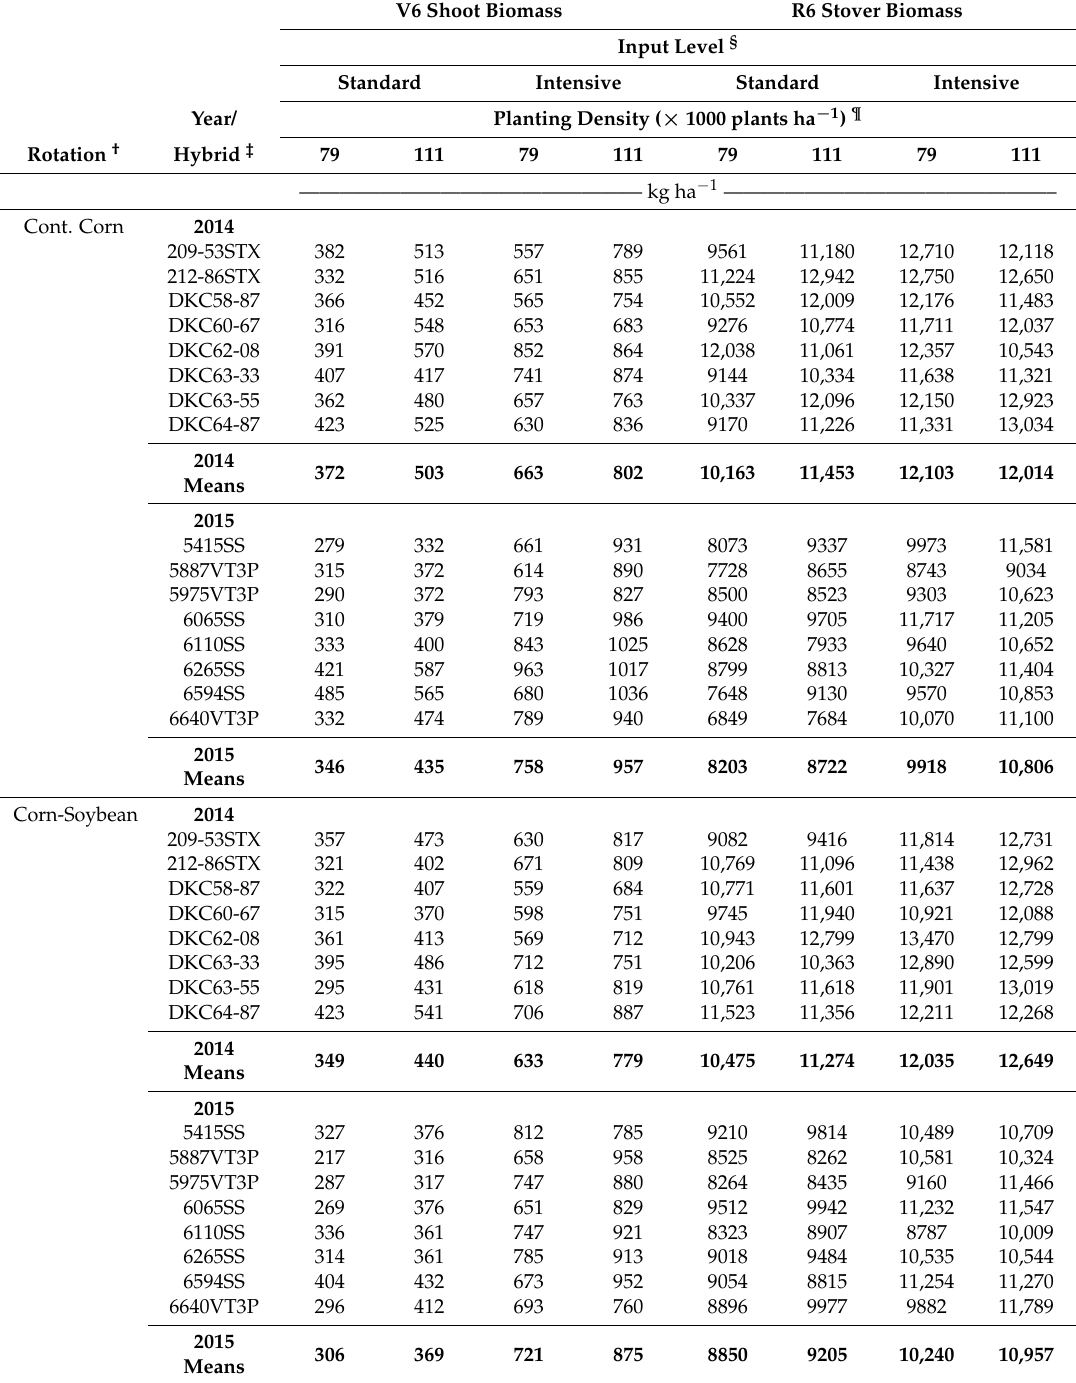
Table 3. Aboveground biomass accumulation as influenced by crop rotation, hybrid, agronomic input level, and population at Champaign, IL in 2014 and 2015. All values are reported at 0 g kg − 1 moisture